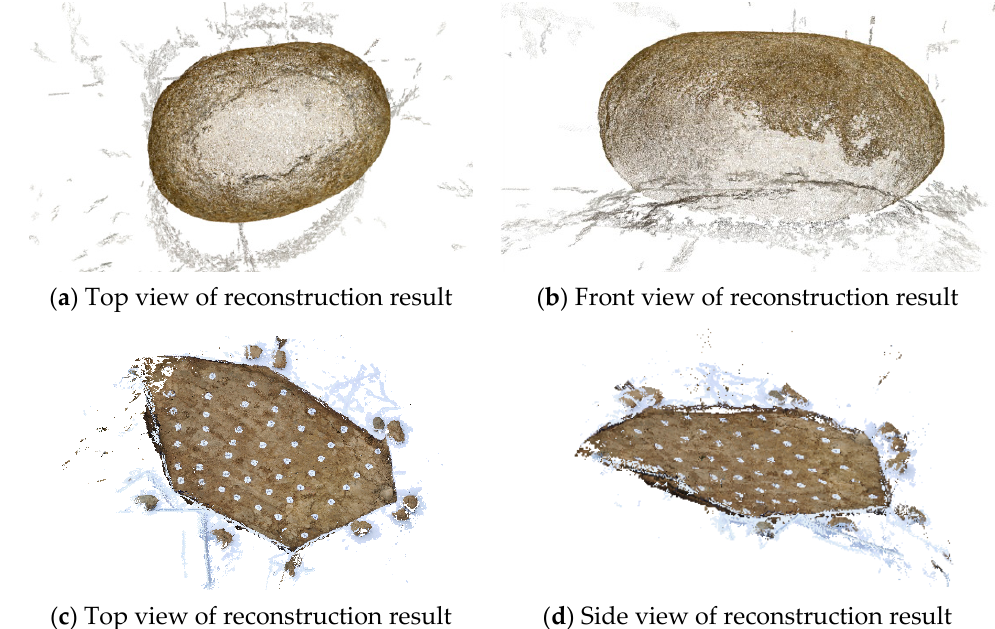
Figure 8. The 3D reconstruction results using the A-SfM (structure from motion) algorithm in experiment 1. Experiment